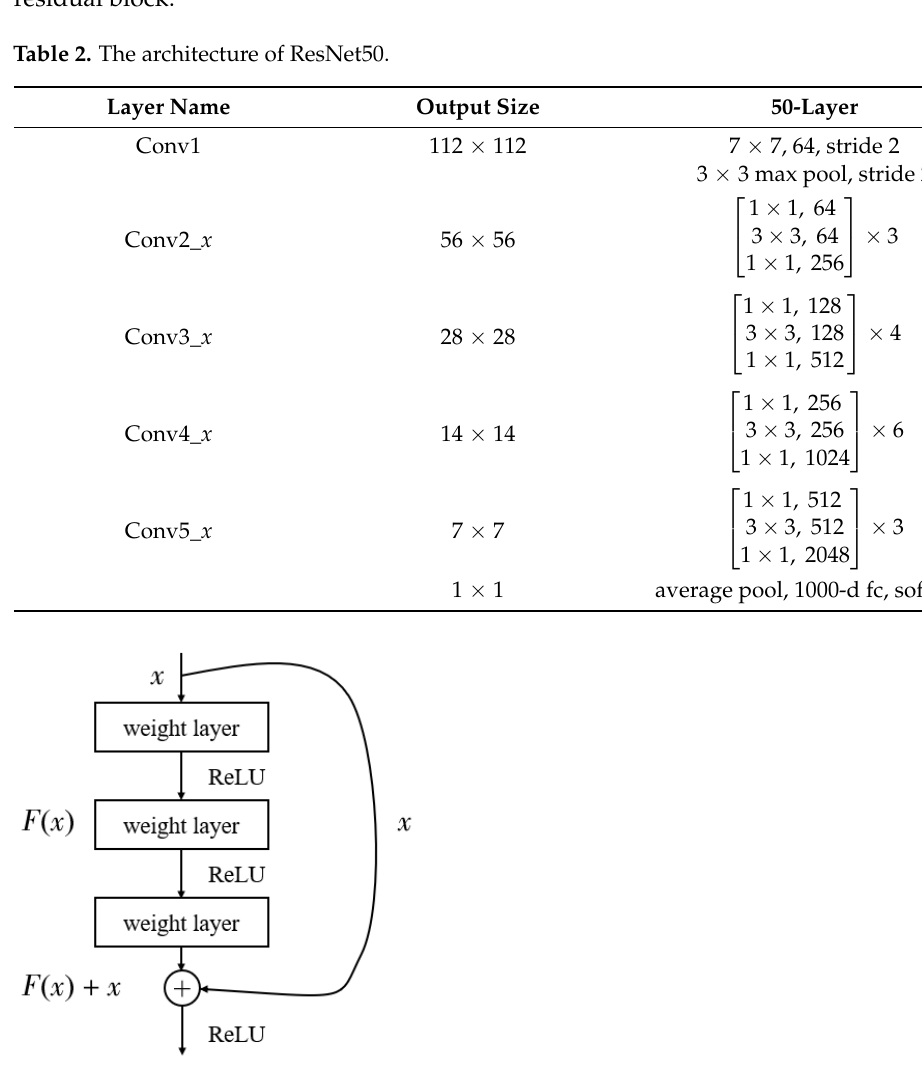
Figure 3. The basic residual building block for ResNet 50.